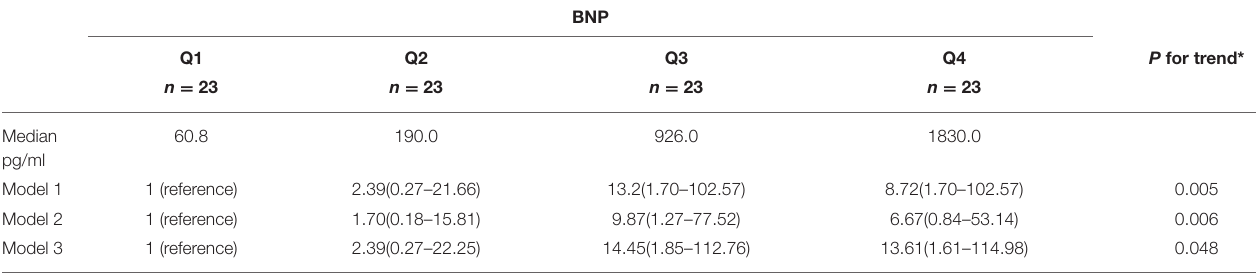
TABLE 3 | Adjusted hazard ratios and 95% confidence interval for BNP by quartiles on all-cause